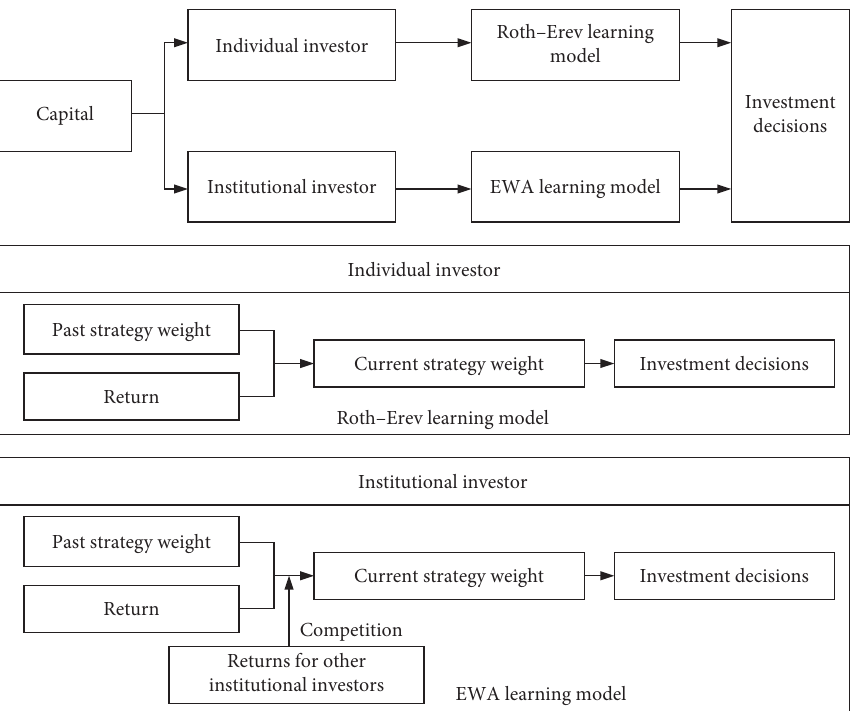
Figure 1: The evolution mechanism of stock market investor’s